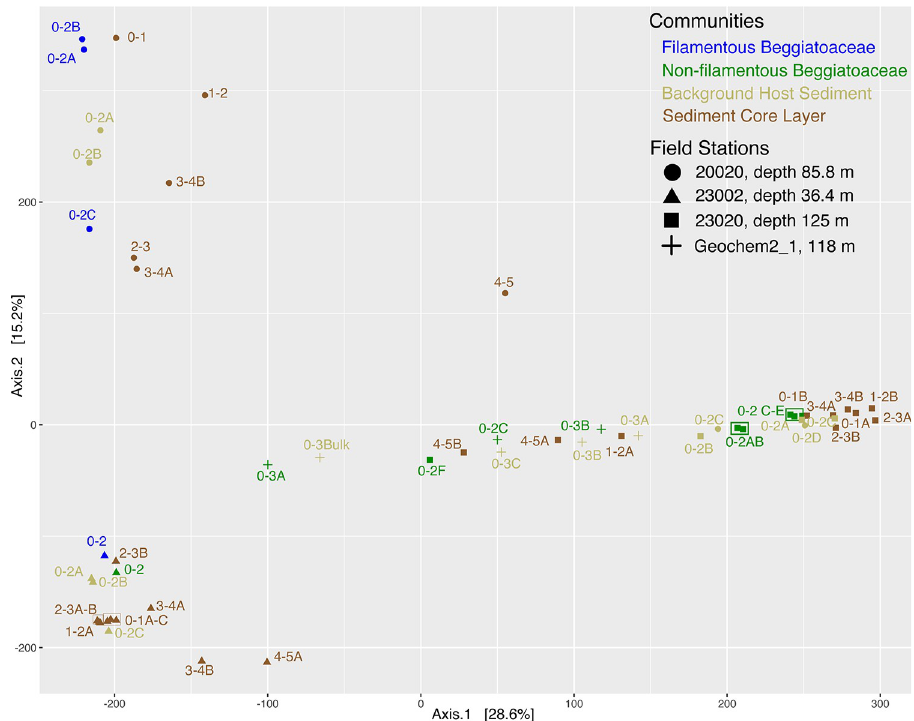
Fig 4. Principal coordinate analysis of 16S rRNA communities of samples collected from four marine stations: 23002, 20020, 23020 and Geochem2_1 and at depths between 0–5 cm. The plot was generated using multidimensional scaling with Euclidean